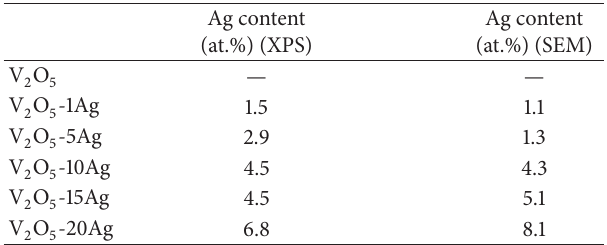
Table 1: Comparison of atomic percent of silver in V 2 O 5 - x Ag photocatalysts measured by XPS and